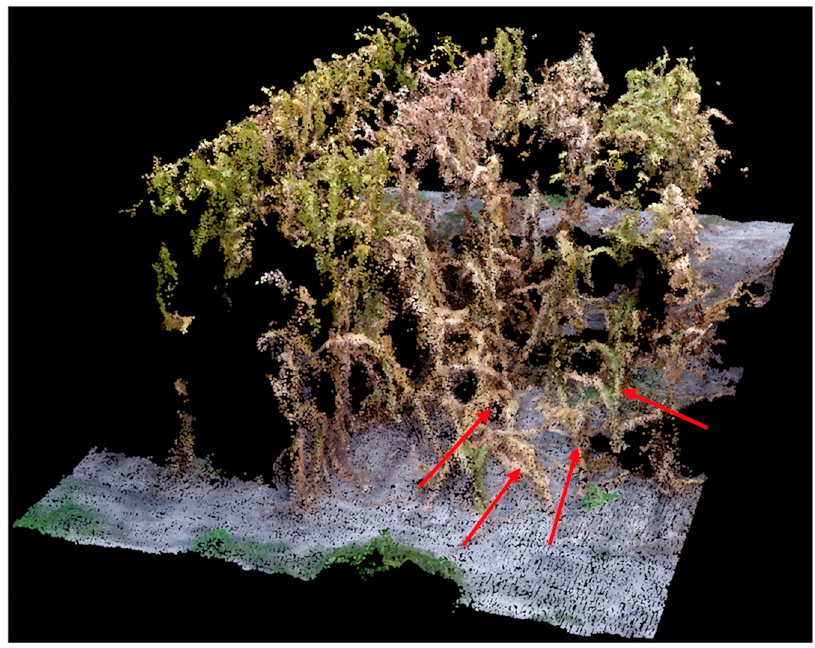
Figure 11. A portion of point cloud-based maize field trial under study in the 3D space demonstrating that the plants significantly bent over (as indicated by red arrows) were mathematically estimated as lodging in the method but were not included by the ground data collector.